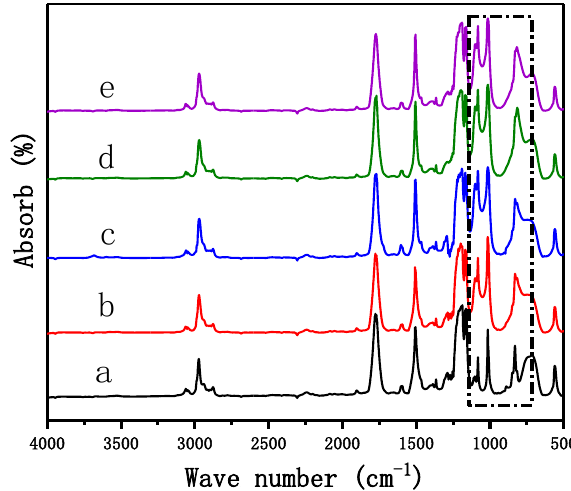
Figure 3. FTIR spectrograms of 0%Si/PC ( a ), 10%Si/PC ( b ), 14%Si/PC ( c ), 18%Si/PC ( d ), and 20%Si/PC ( e ).